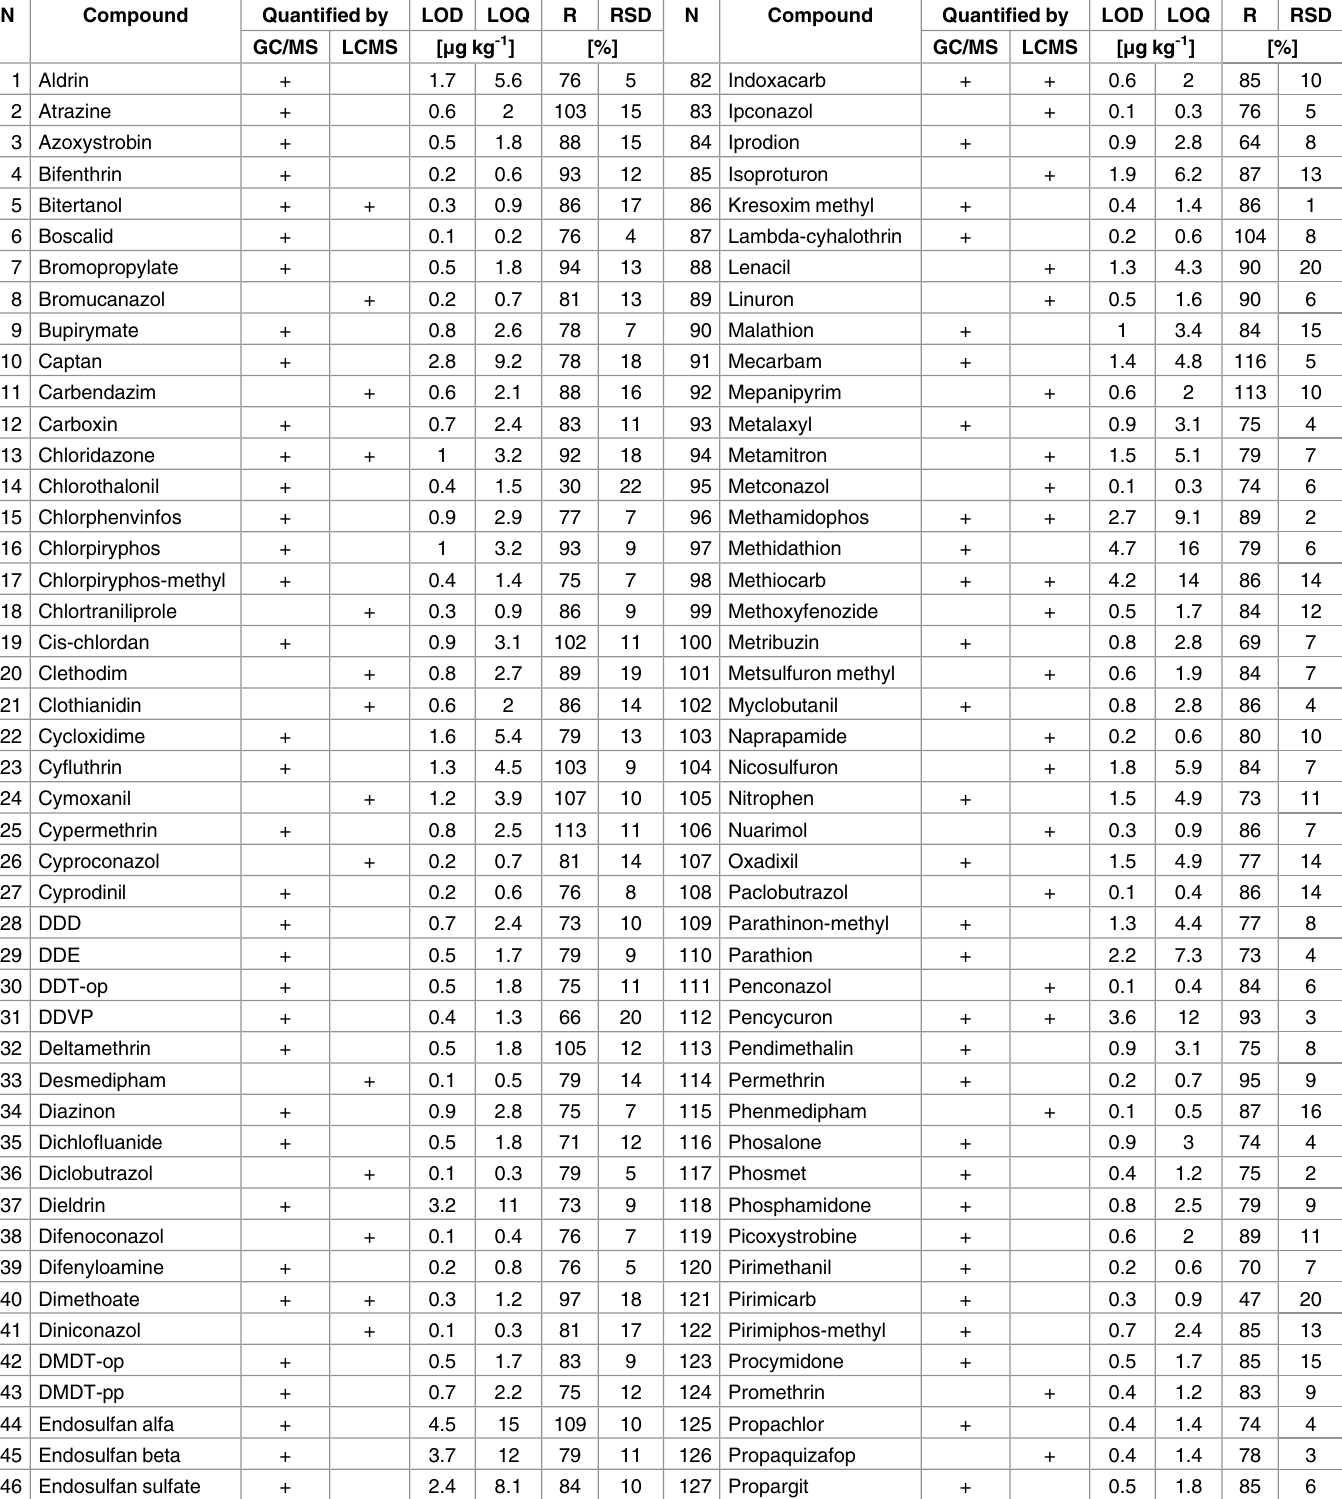
Table 1. Determinedcompounds, applied quantification technique, and performanceof the developed analytical method (spiked samples, n = 15). N